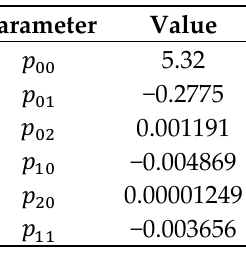
Table 1. Parameters of the pass distance forecast according to Equation (2) confidence bounds of 95%.